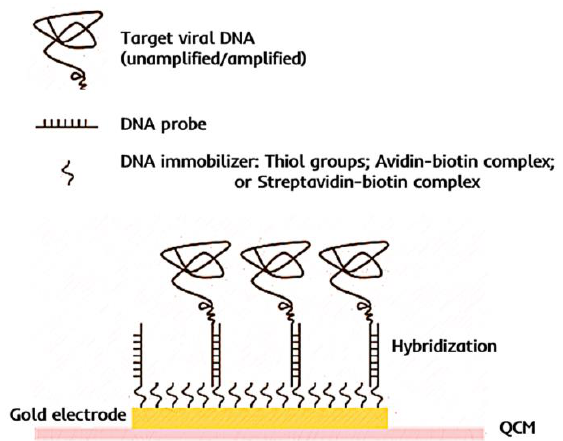
Figure 7. A schematic representation of the DNA-QCM virus sensor. DNA probe is attached to